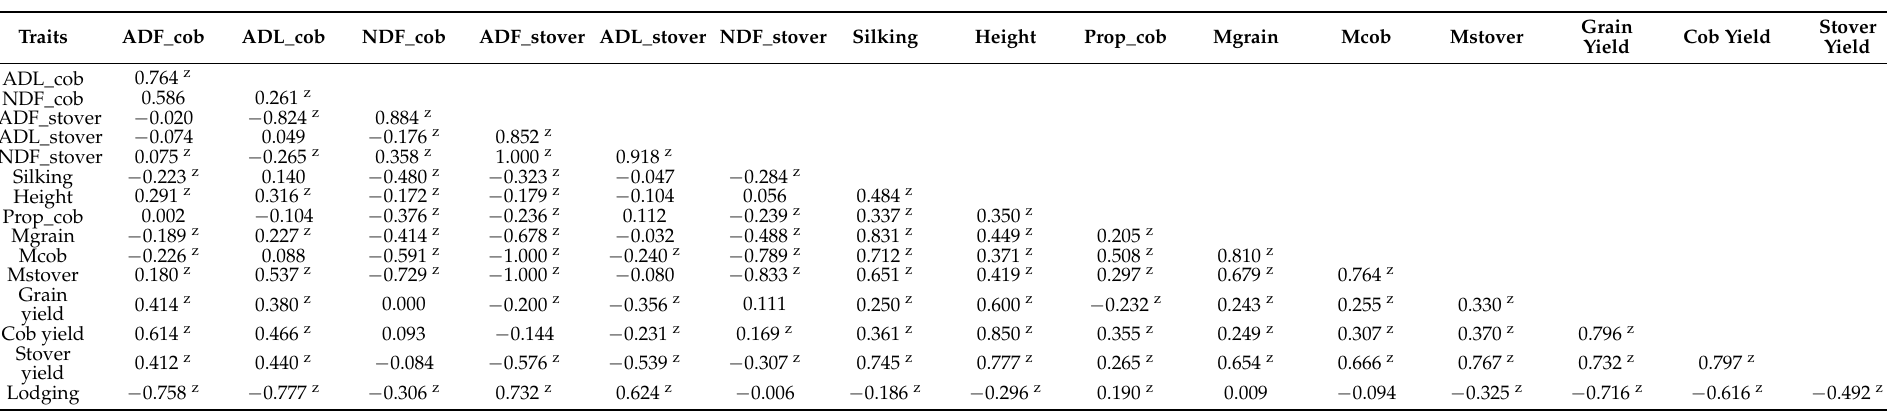
z Significant pairwise genetic correlations at 0.05